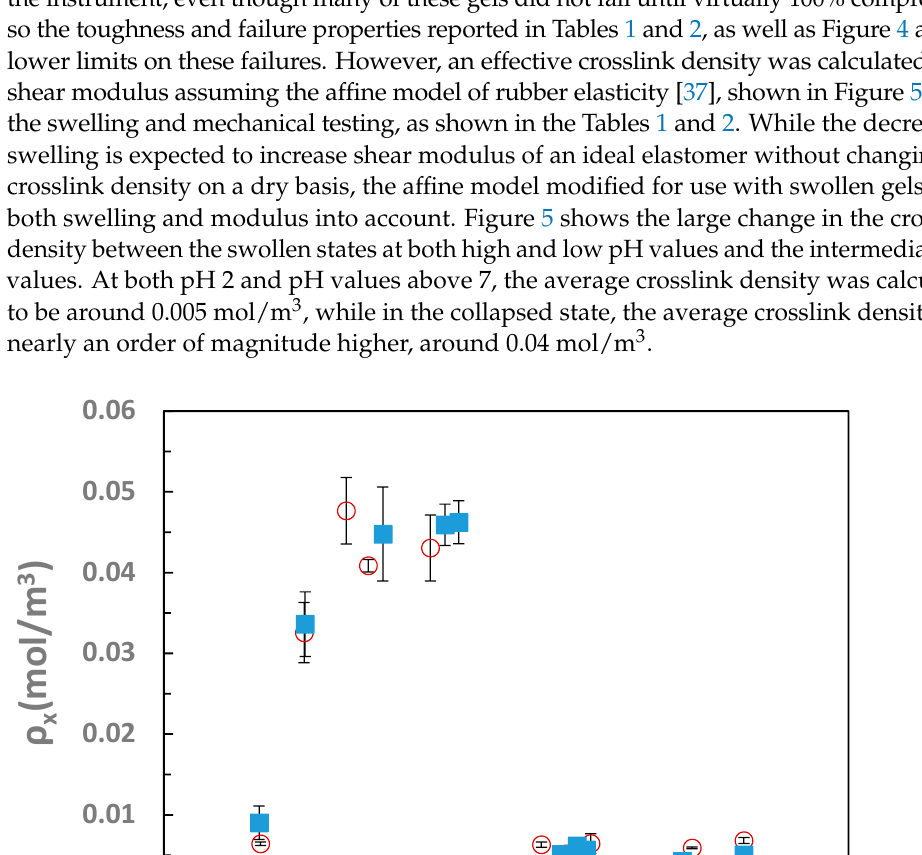
Figure 6. Repeated loading of a partially hydrolyzed PAA/PNVF hydrogel. After five high strain compression cycles there was negligible change in the stress–strain curves of the hydrogel, indicat- ing the hydrogel did not undergo any irreversible damage due to repeated loading cycles.